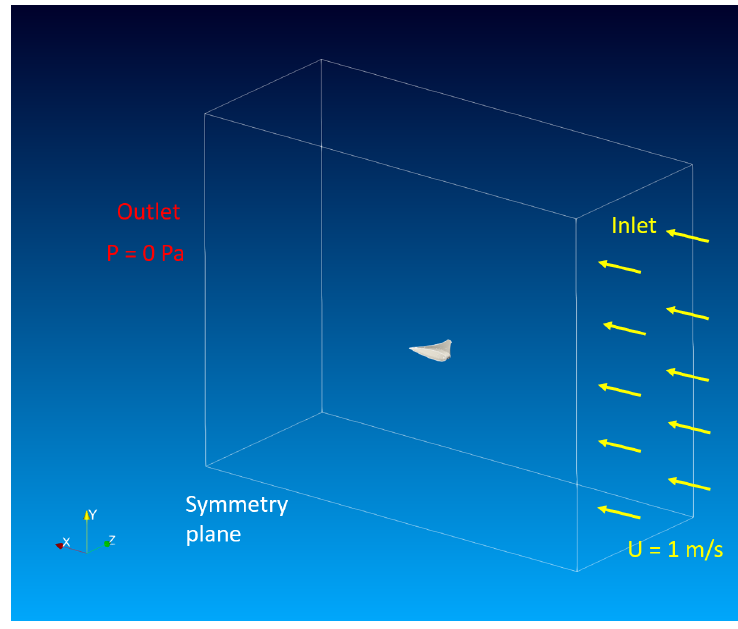
Figure 10. Domain of the CFD analysis and boundary